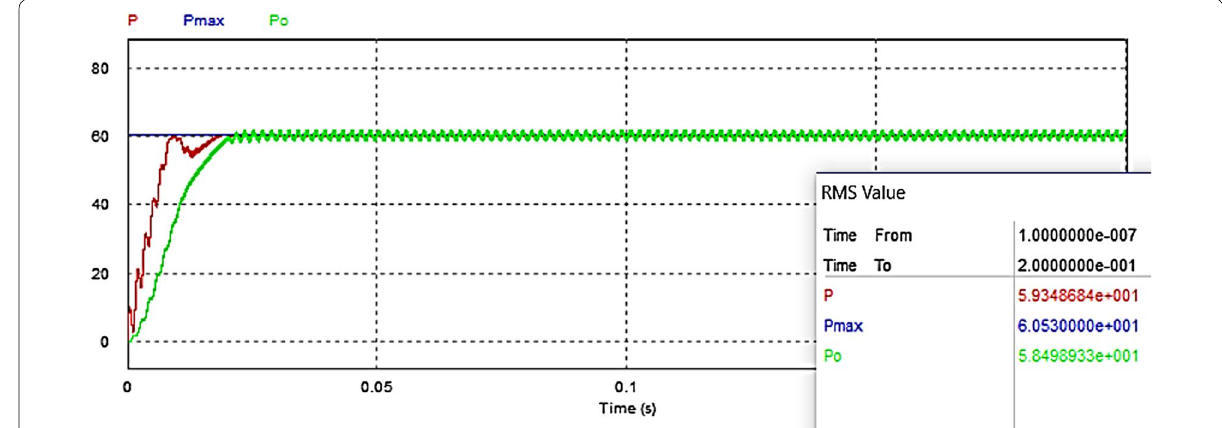
Fig. 8 Output powers for INC algorithm under STC